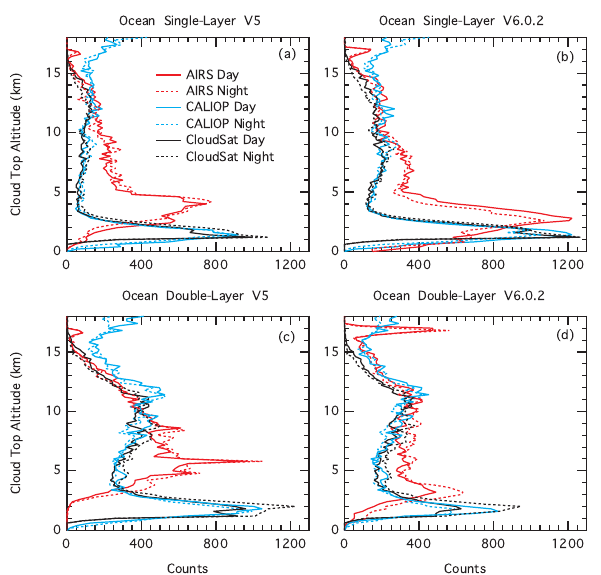
Fig. 4. Same as Fig. 3, except for land. ECF > 0.01 are included). Improvement for the low clouds over land is even greater than over the ocean. However, a sharp peak in high thin cloud is observed near 17 km unlike the ocean cases. An improvement in the realism of the broad peaks near 8–12 km is observed in v6 and is more consis- tent with the active sensors. In summary, the AIRS v6 cloud top height distributions are significantly improved over v5, although AIRS still struggles with locating the height of the thinnest cloud near the